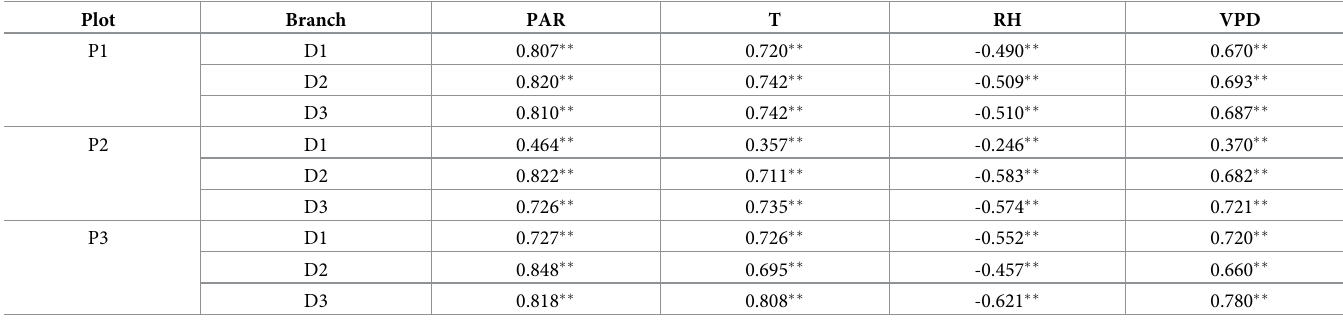
Note “ �� ”indicates that the correlation is significant at the 0.01